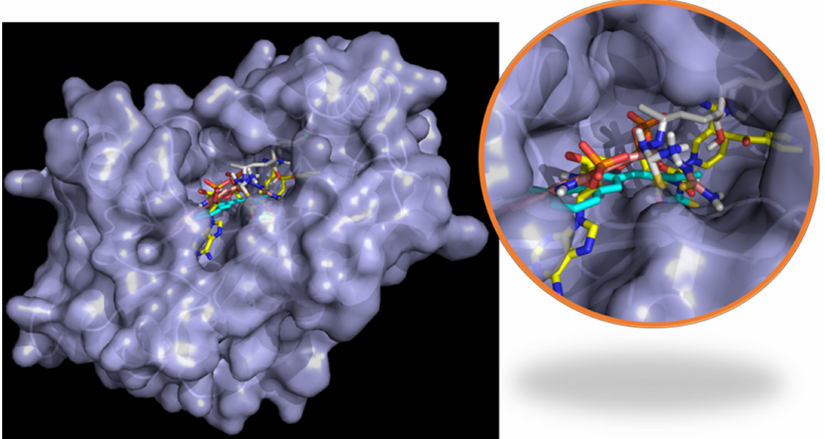
Figure 8. Final pose of 11c (cyan), 11d (gray), and 11e (pink) after the 200 ns compared with (4S)- isonicotinic-acetyl-nicotinamide-adenine dinucleotide (yellow) present in the ligand in enoyl-acyl reductase (blue) crystal